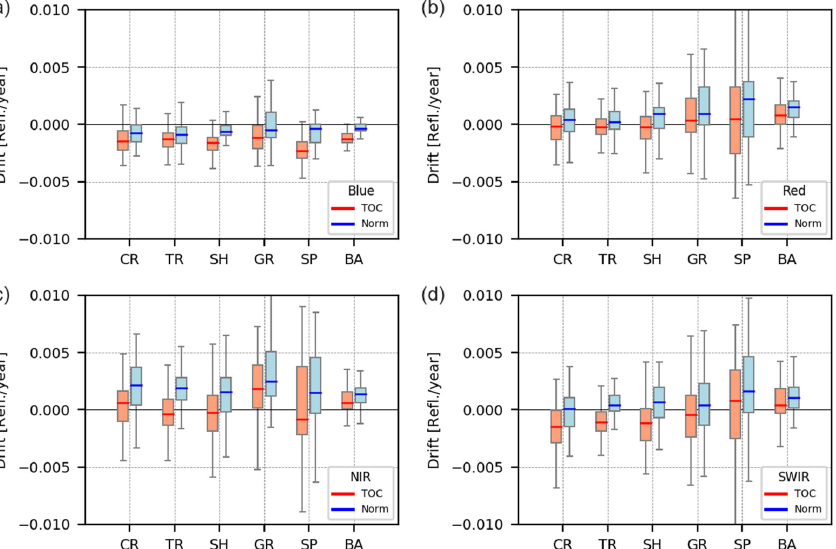
Figure 15. The figure shows the boxplots of estimated drifts in the four spectral bands when all angular observations are merged. The statistics are aggregated per land cover class: Crop (CR), Tree (TR), Shrubland (SH), Grassland (GR), Sparse vegetation (SP), Bare soils (BA). Estimated drifts for TOC (red) and BRDF-normalized (blue) reflectances are presented for the bands: ( a ) Blue, ( b ) Red, ( c ) NIR, ( d ) SWIR. The parameters of the boxplot chart are those used and described in Figure 12.